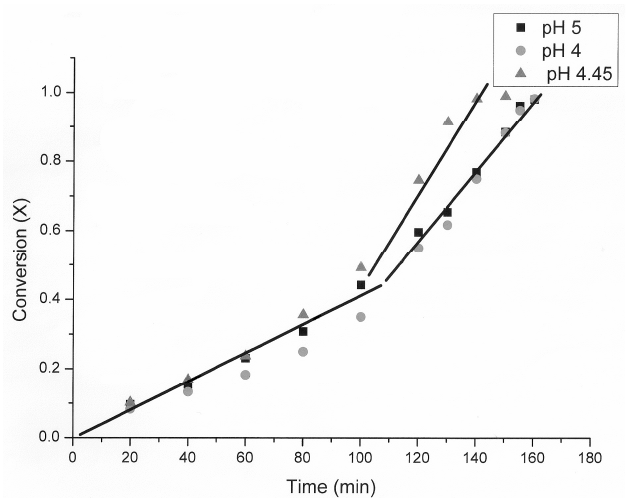
Figure 6. Effect of H 3 O + concentration on thiosulfate transformation: [S 2 O 32− ] initial , 1 g·L −1 ; [Cu 2+ ] initial , 0.053 g·L −1 ; 60 °C; O 2 pressure, 1 atm.